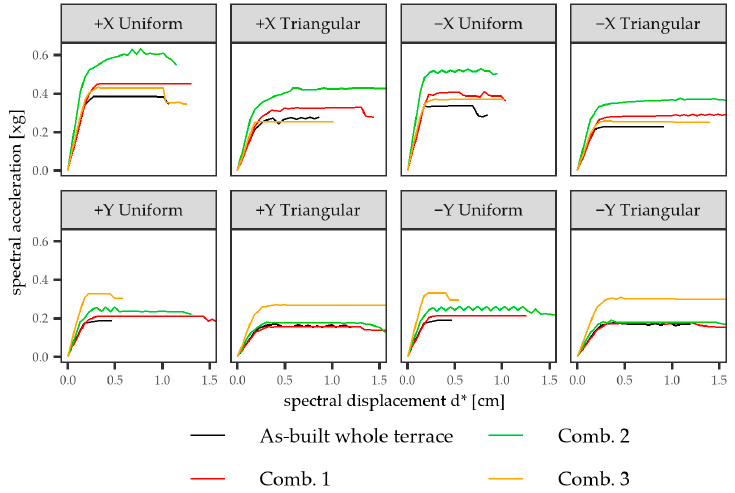
Figure 15. Whole-terrace model: normalized pushover analyses in strengthened conditions, compared to as-built.